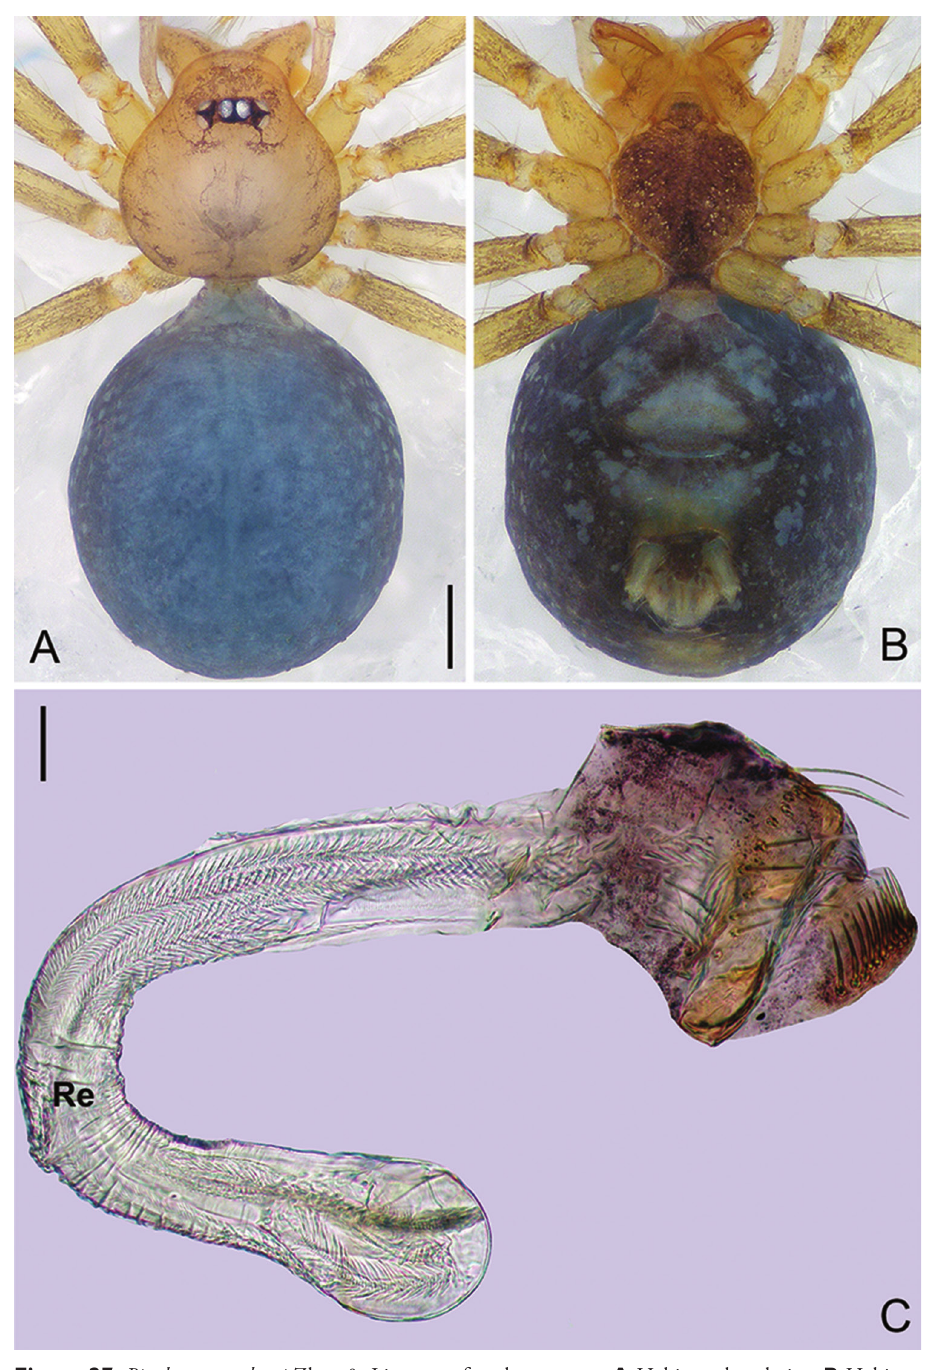
Figure 27. Pinelema yunchuni Zhao & Li, sp. n., female paratype. A Habitus, dorsal view B Habitus, ventral view C Endogyne, lateral view. Scale bars: 0.2 mm ( A–B ), 0.05 mm ( C